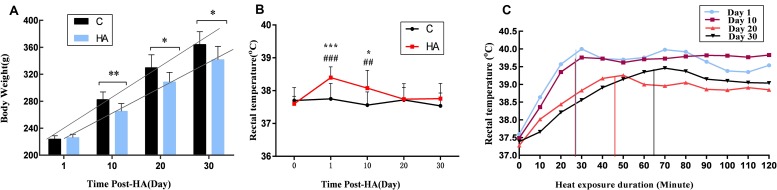
Data are expressed as mean ± SD. HA, heat acclimation (n = 17); C, control (n = 11). ∗P < 0.05, ∗∗P < 0.01, ∗∗∗P < 0.001 compared with the C group. ##P < 0.01, ###P < 0.001 compared with the same group before heat exposure. P < 0.05 was considered statistically significant. (A) Rats weight in the HA group was significantly lower than C group (P = 0.003 for 10 days, P = 0.011 for 20 days, and P = 0.019 for 30 days). (B) Tre in the HA group on days 1 and 10 differed significantly from that in the C group after heat exposure (P = 0.000 for 1 days and P = 0.025 for 10 days); there was a significant difference of Tre in the HA group after heat exposure on days 1 and 10 compared with the same group before heat exposure (P = 0.000 for 1 day and P = 0.004 for 10 days). (C) During 2-h continuous monitoring, Tre showed an initial rising trend, followed by a decrease and gradual stabilization. There was no difference in Tre between the HA and C groups on day 30.